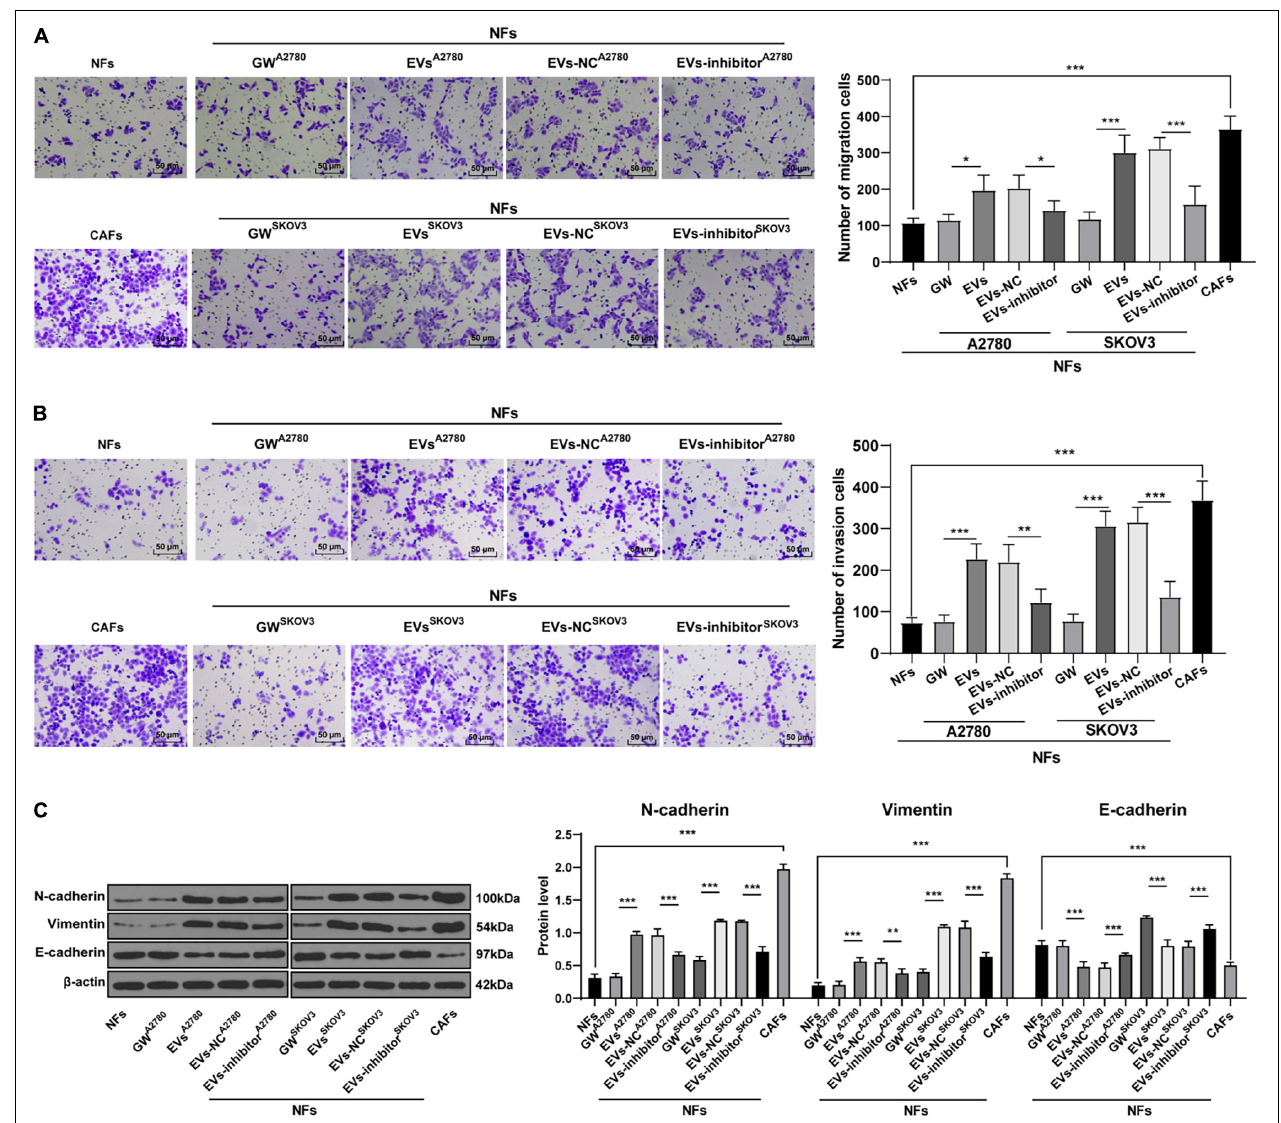
FIGURE 8 | Extracellular vesicles promoted invasion and metastasis of OC cells by carrying miR-630. The culture supernatant of NFs in each group was collected, and then this conditioned medium was used to culture OVCAR8 cells. The cultured OVCAR8 cells were collected. (A,B) Migration and invasion of OVCAR8 cells were measured using Transwell assays; (C) EMT-related proteins ( N -cadherin, Vimentin, and E -cadherin) of OVCAR8 cells in each group were detected using Western blotting. The experiment was repeated three times independently. Data are presented as mean ± standard deviation and analyzed using one-way ANOVA, followed by Tukey’s multiple comparison test, ** p < 0.01, *** p < 0.001. A2780 and SKOV3 indicated the source of